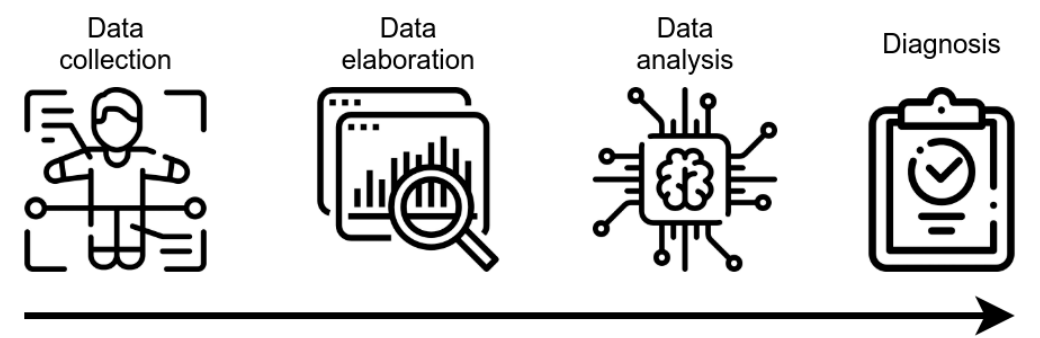
Figure 2. Schematic representation of CAD tools functioning. After collection, data are elaborated, in order to be made ready for the analysis using AI-based techniques. The outcoming result is the assignment of a class, with potential value for diagnostic evaluation.